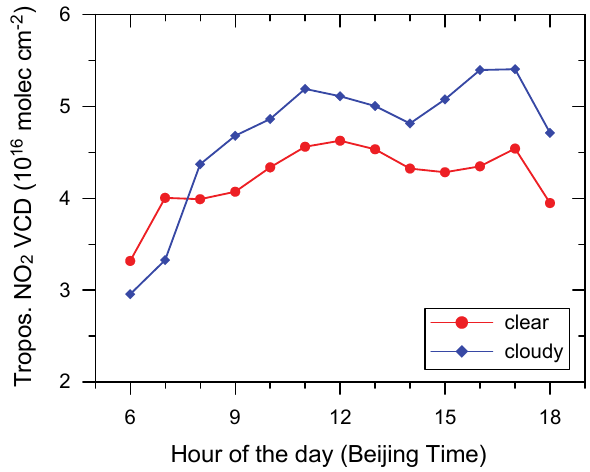
Fig. 10. Diurnal variations of the tropospheric NO 2 VCD in August for the years of 2008, 2009, 2010 and 2011. The bars refer to the standard deviations.